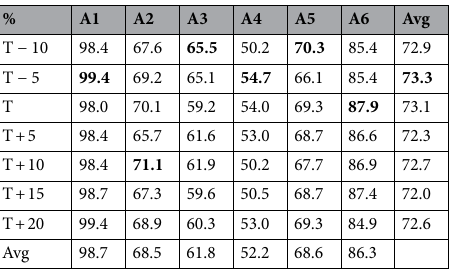
Table 7. Classification results for the masked unwrapped phase data domain, with patent features and different threshold values.